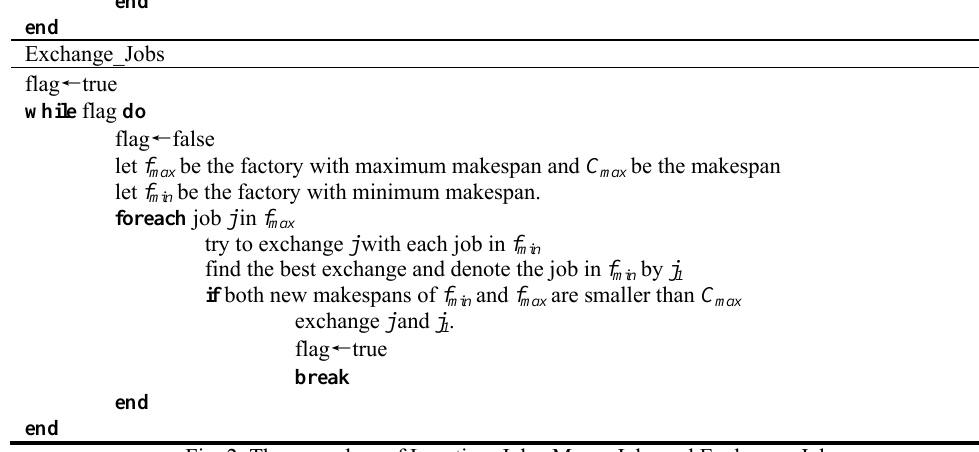
Fig. 2. The procedure of Insertion_Jobs, Move_Jobs and